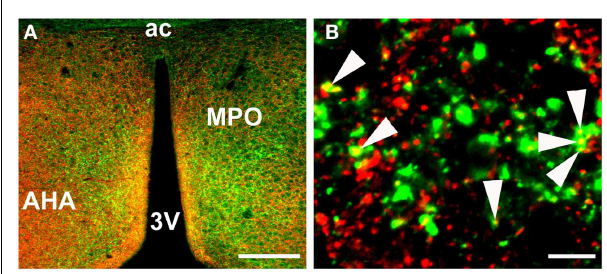
FIGURE 3 | Colocalization of PTH2R fibers andVGluT2 punctae in the anterior hypothalamus as detected by immunohistochemistry. (A) a low magnification image of PTH2R (green) andVGluT2 (red) expression in the region of the medial preoptic area. (B) a high magnification image of PTH2R/VGluT2 colocalization, where some of the colocalized points are indicated with arrowheads. Abbreviations: 3V, third ventricle; ac, anterior commissural; AHA, anterior hypothalamic area; MPO, medial preoptic nucleus of the hypothalamus. Scale bars = 200 µ m for A and 10 µ m for B.